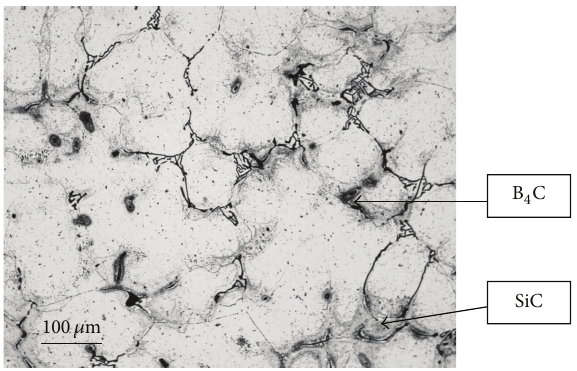
Figure 2: Microstructure of the composite.